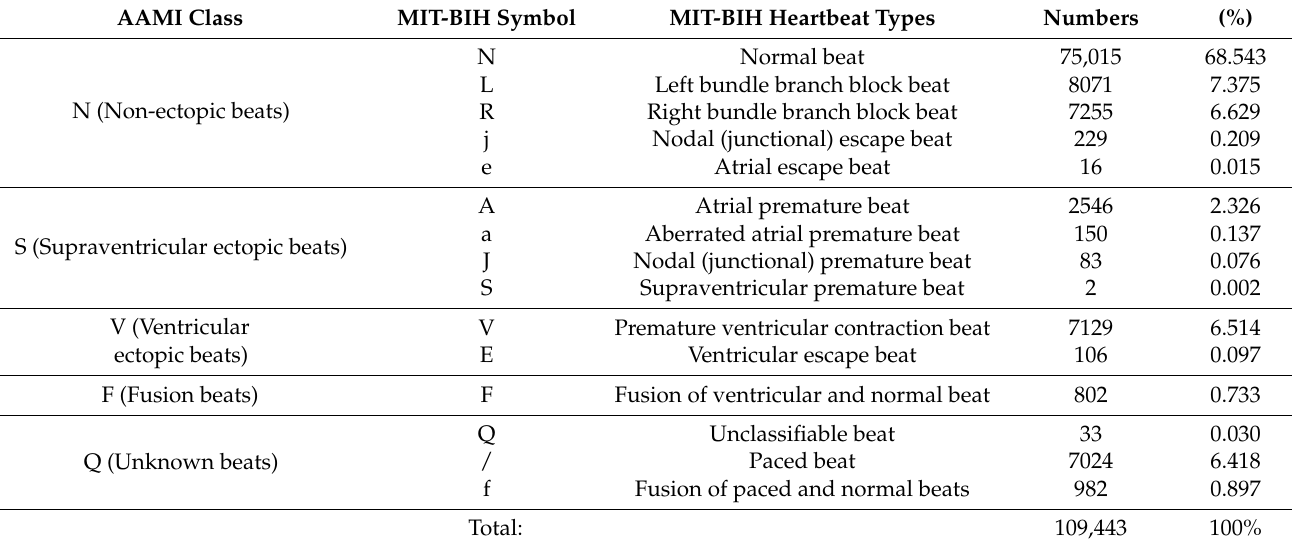
Table 2. Sample numbers in the MIT-BIH arrhythmia database and class description using the AAMI standard.